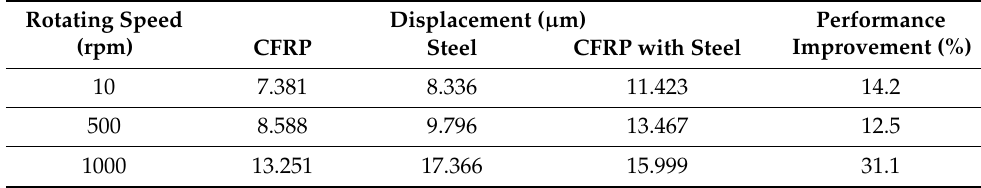
Table 10. Displacement of fastening